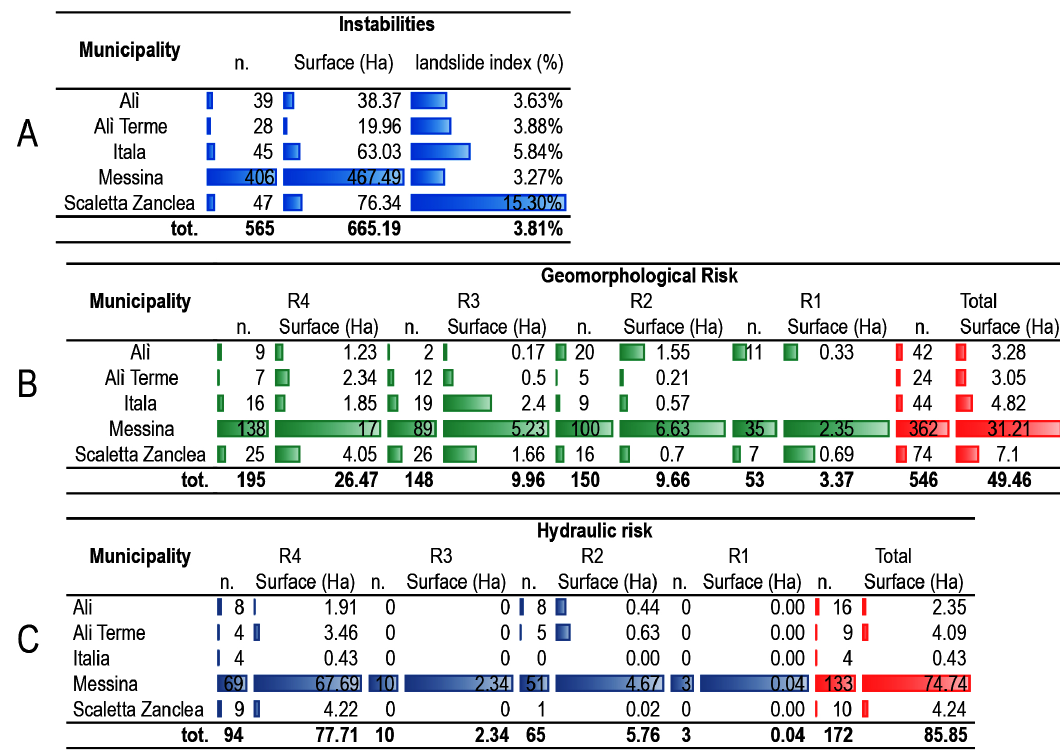
Figure 5. Synthesis of the entity and extension of instabilities and risk in each of the municipalities of the damaged area: ( A ) Instabilities (landslide index is a percentage than the whole municipality territorial area); ( B ) Geomorphological Risk; ( C ) Hydraulic